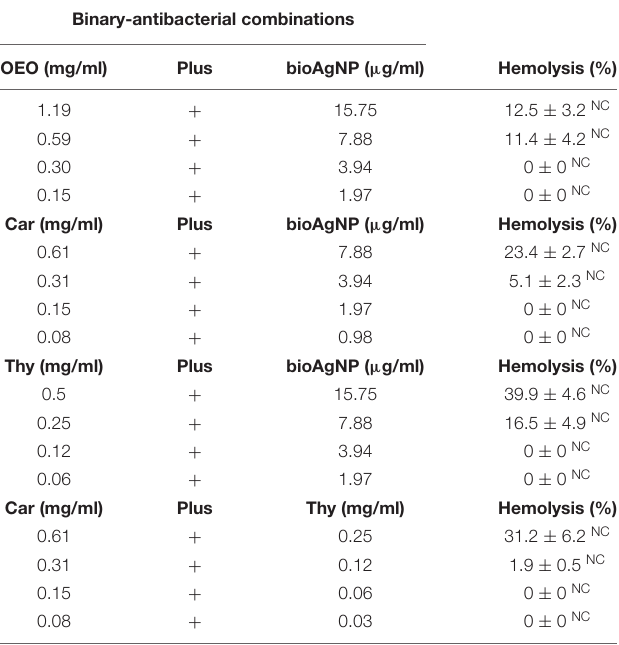
TABLE 6 | Hemolytic activity of the four binary antibacterial combinations (OEO plus bioAgNP, Car plus bioAgNP, Thy plus bioAgNP, and Car plus Thy). Binary-antibacterial